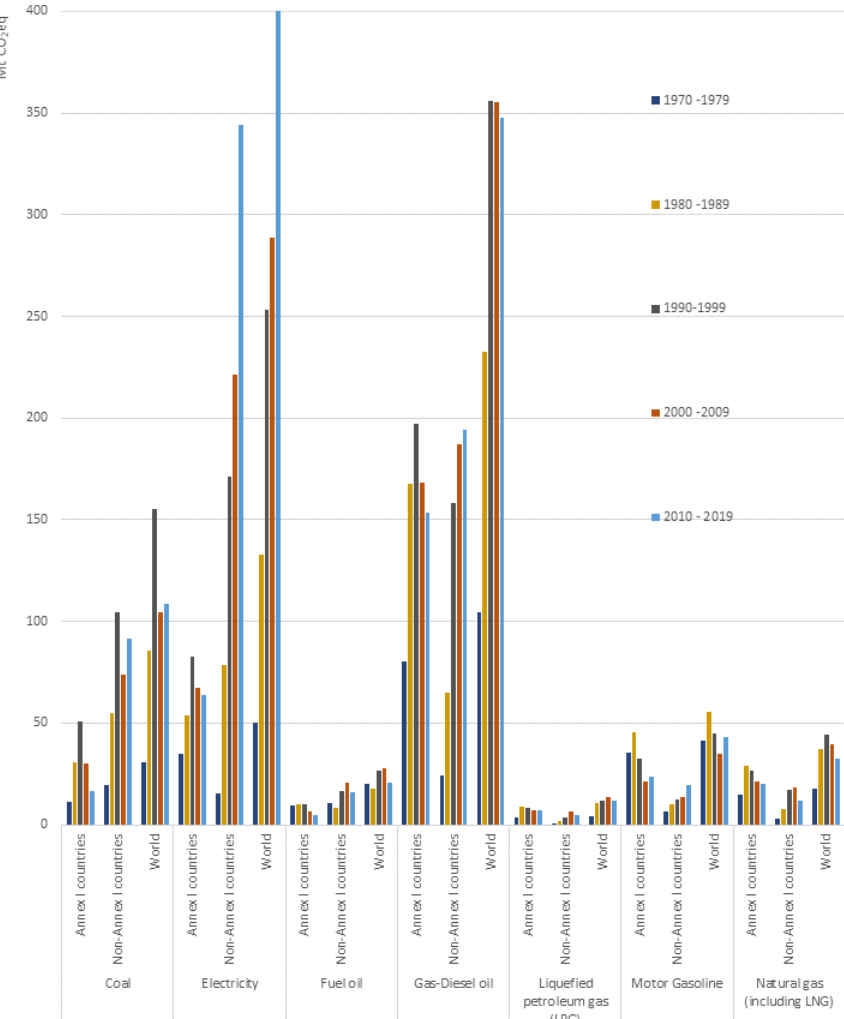
Figure 2. GHG emission trends from 1990 to 2019 for Annex I and non-Annex I countries by energy carrier (MtCO 2 eq). Source: FAOSTAT,